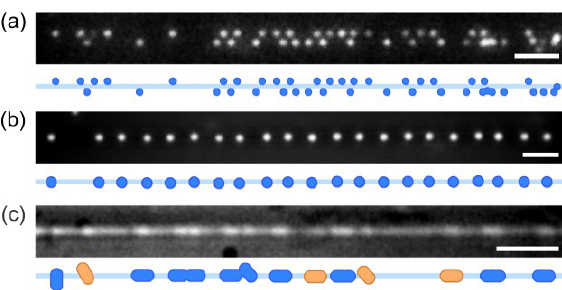
Fig. 2. Periodic arrangement of 500 nm polystyrene beads trapped in staggered rows. (b) Periodic arrangement of 1µm polystyrene beads above the waveguide. (c) Stable trapping of several e.coli bacteria above a single waveguide.